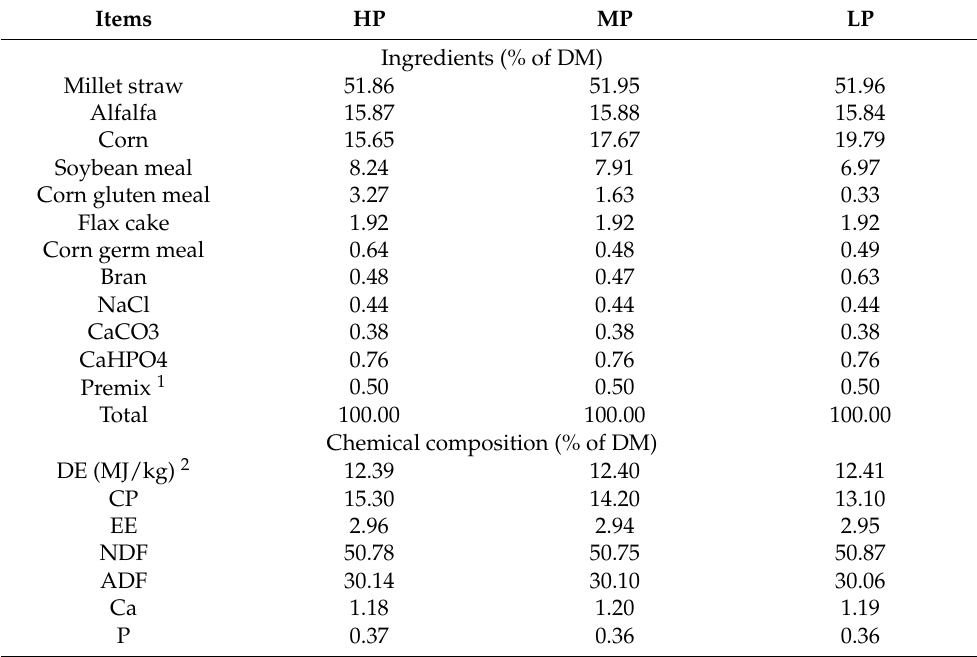
Table 1. Composition and nutrient levels of basal